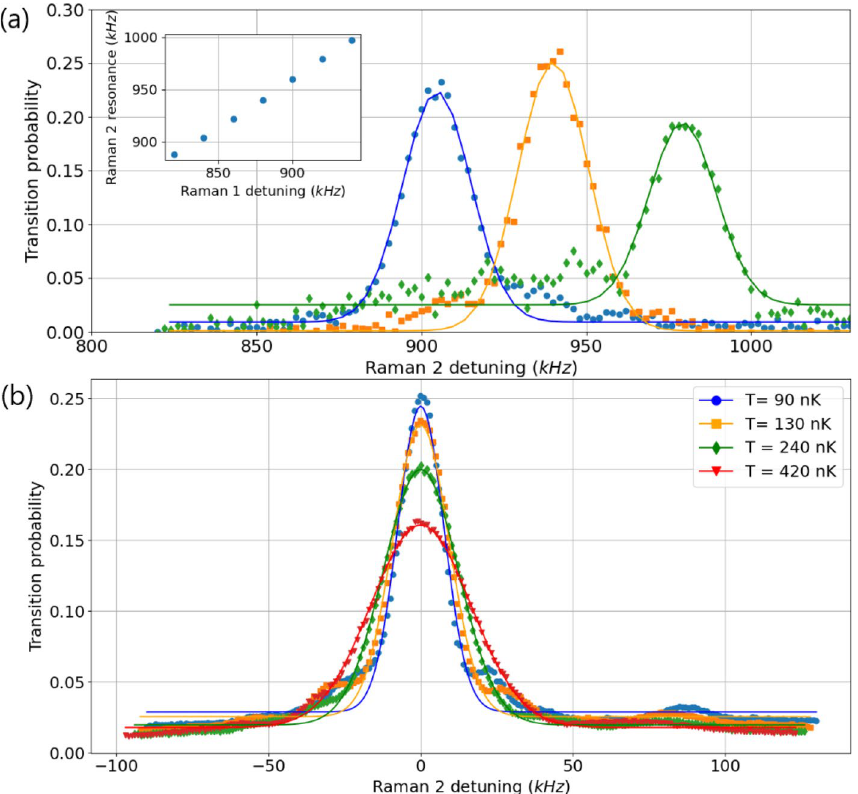
Figure 8. ( a ) Raman spectroscopy performed with the upper Raman beam (Raman 2), for three different mean velocities selected with the lower Raman beam (Raman 1). The peaks correspond to three different Raman 1 frequencies incremented by 40 kHz steps. Inset: Raman 2 resonance as a function of Raman 1 frequency. The offset between the two frequencies is due to a difference in vertical velocity when the atoms cross the beam leading to a different Doppler shift. ( b ) Raman spectroscopy performed with the upper Raman beam (Raman 2), for four different velocity spreads selected with the lower Raman beam (Raman 1). The legend gives the corresponding effective temperatures deduced from a gaussian fit of the peak.